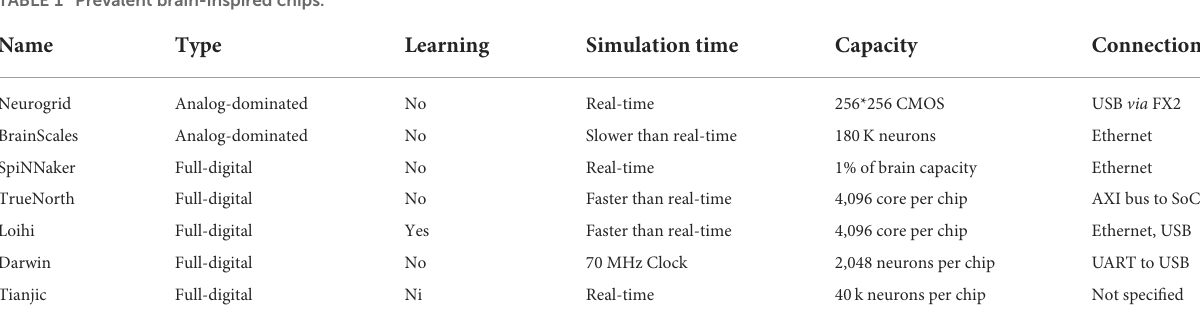
Table 1 introduces prevalent brain-inspired